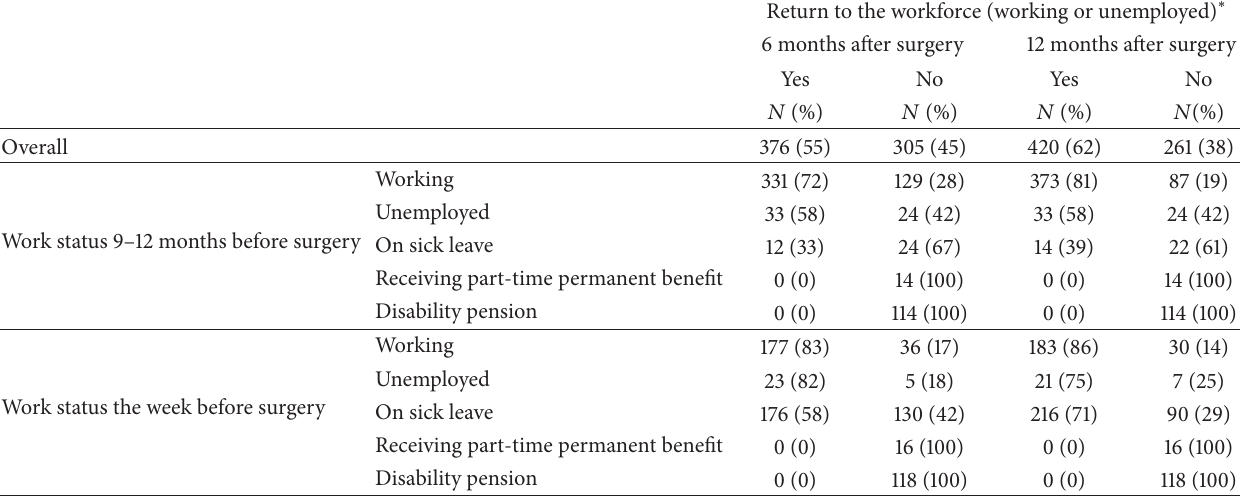
Table 2: Return to the workforce 6 and 12 months after surgery for patients undergoing CABG and/or heart valve surgery in the North Denmark Region from 2003 to 2007.